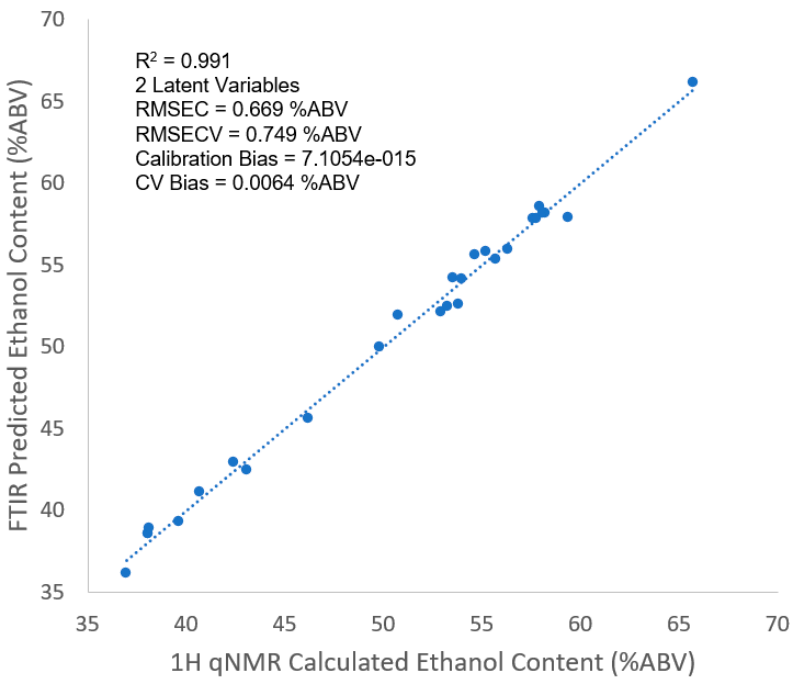
Figure 10. PLS correlation plot showing the prediction of ethanol content (%ABV) by FTIR-ATR spectroscopy correlated to the 1 H qNMR calculation of the ethanol content of 27 authenticated baijiu samples.